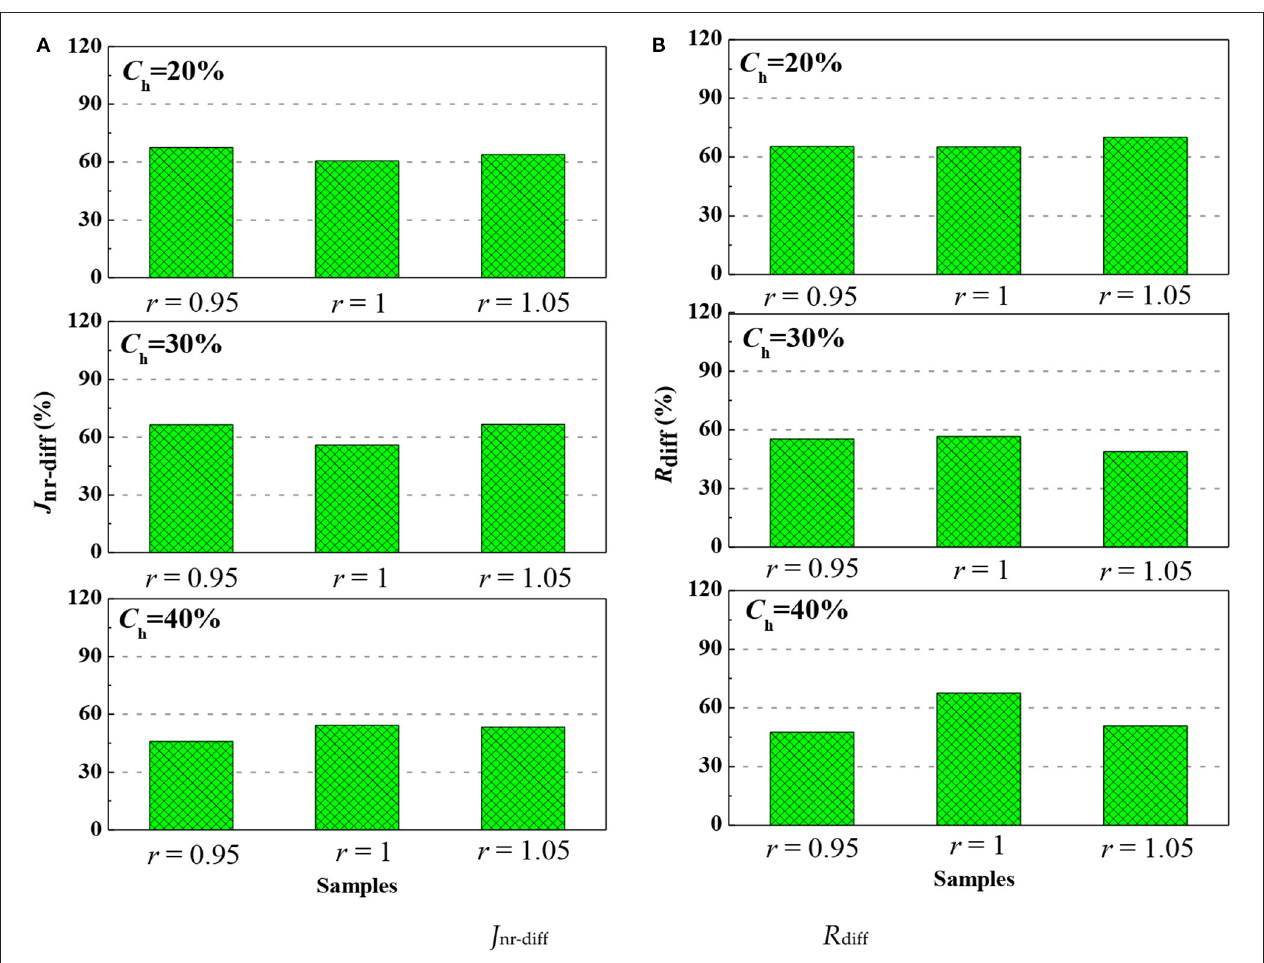
FIGURE 34 | Change the rules of stress sensitivity (Polyester-based TPU). (A) J nr − diff . (B) R diff